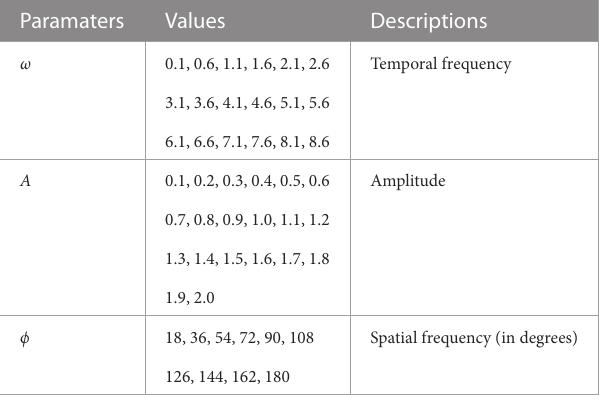
ensure a fair comparison, the actuation range of the rigid snake robot’s joints was set to [−36°, 36°] to match the total actuation range of the soft snake robot, which has 12 active joints per segment, each with an actuation range of [−3°, 3°] (−36°, 36° in total). The range of the output torque of the active joint is set to [−12, 12] Nm. Twelve times